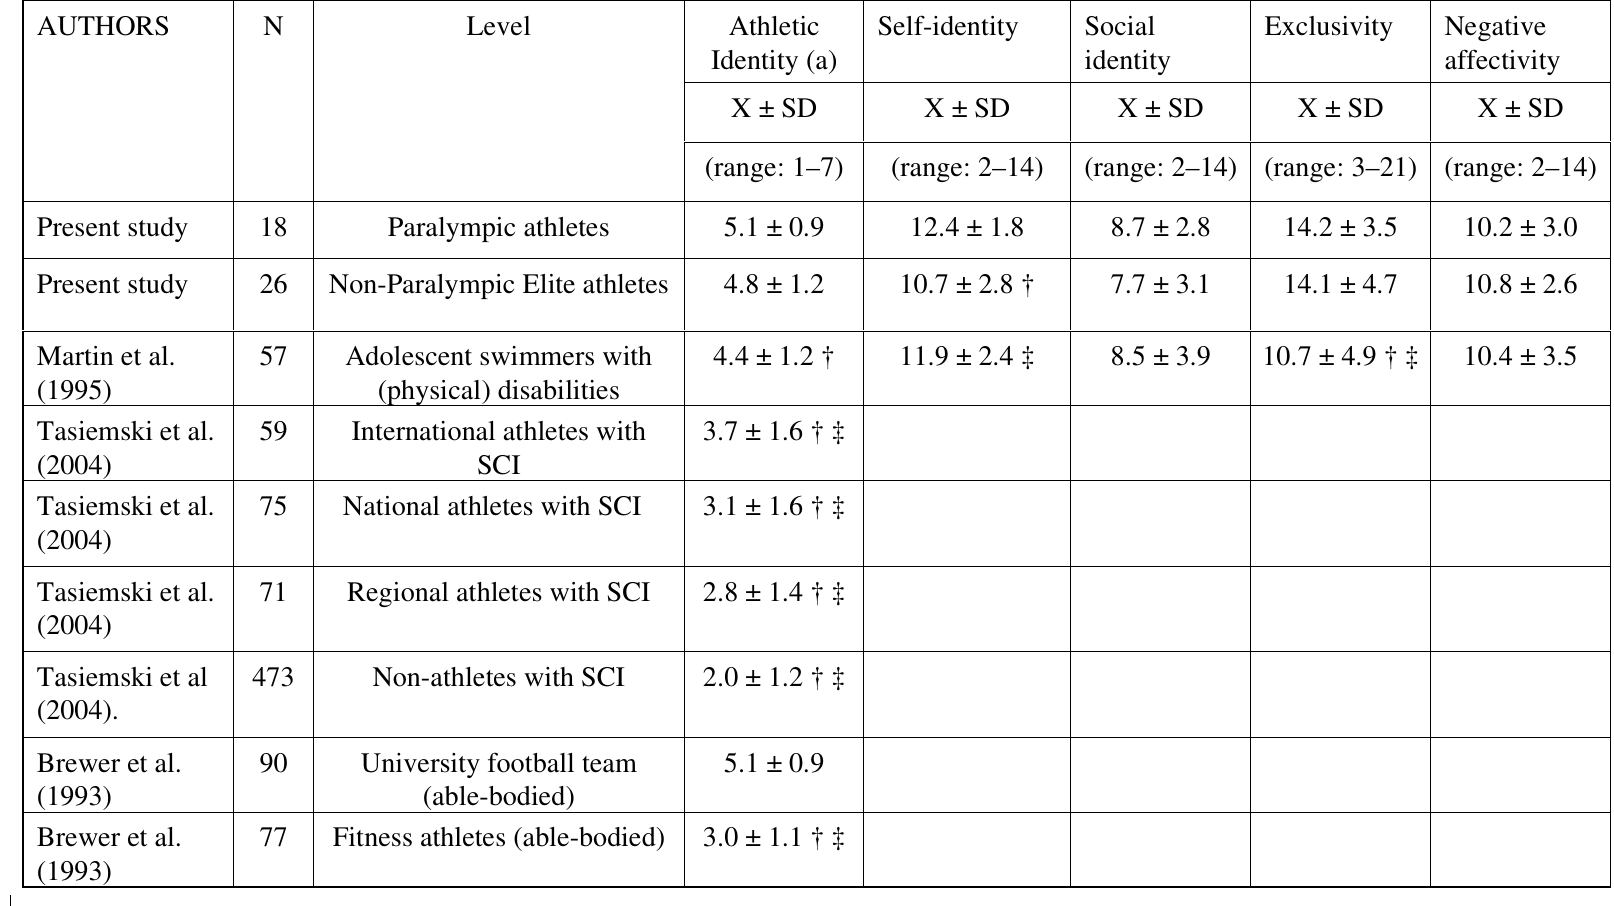
Table 1 Athletic identity in Flemish Paralympic and Non-Paralympic elite athletes in comparison to other athletes with a disability and able-bodied athletes and non-active individuals [comparisons made at time 1, 11 months prior to Paralympic Games]